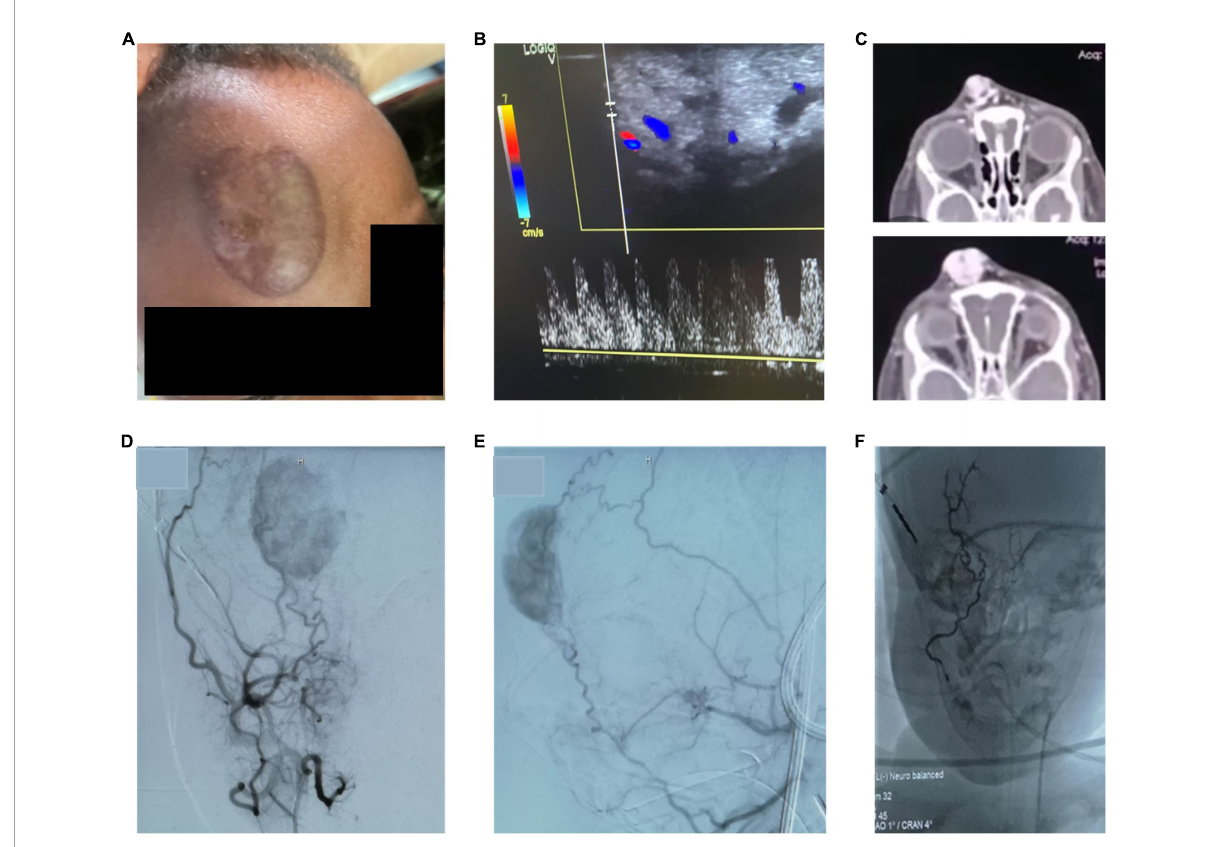
FIGURE4 (A,B) Pre-procedural picture of a clinical examination showing a pulsatile, warm AVM of the forehead with corresponding high flow on doppler ultrasound. (C) CT-images with contrast show a highly vascularized lesion with arterial feeders and venous drainage via the ophthalmic veins. (D,E) Angiographic images of the AVM by contrast administration through the external carotid artery confirm the facial artery as the major feeding vessel. Further, the frontal branch of the temporal artery has small feeding branches. (F) After embolization of the main feeding vessels with liquid embolic material occluding the arterial vascular network, the intravascular cast formed by the liquid embolic agent can be appreciated. The patient underwent subsequent surgical resection of the